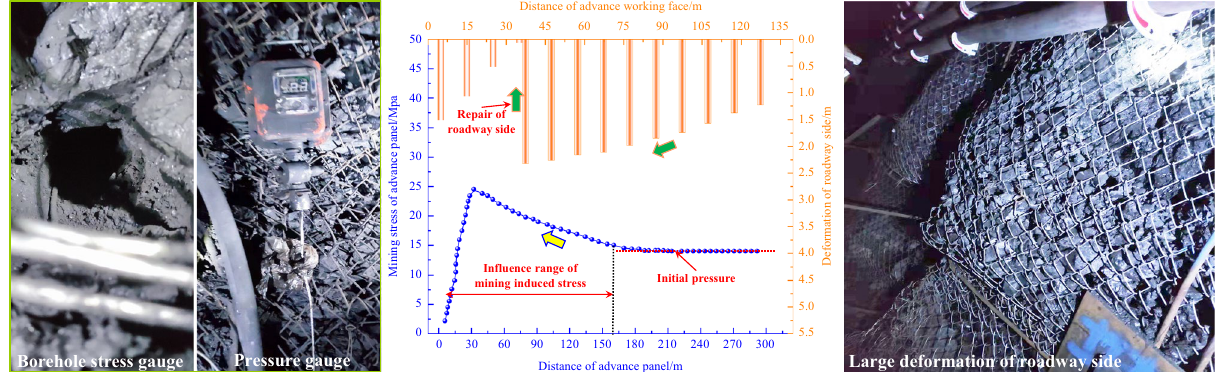
Figure 4. The influence range of mining induced stress in the panel and the deformation of both sides of the mining roadway.